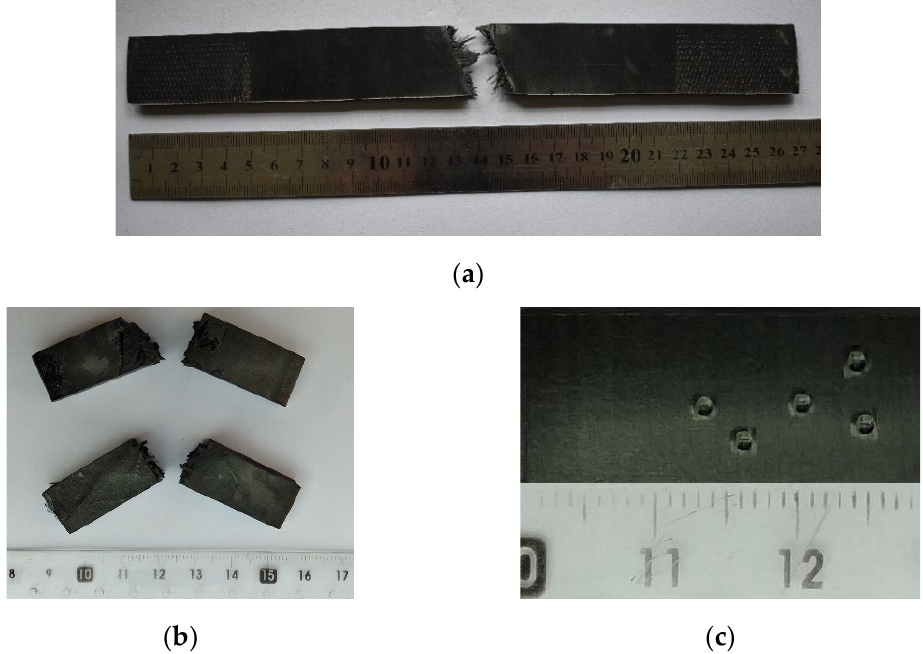
Figure 6. Test coupons for ( a ) tensile strength testing, ( b ) impact toughness test, ( b , c ) Rockwell hardness test.